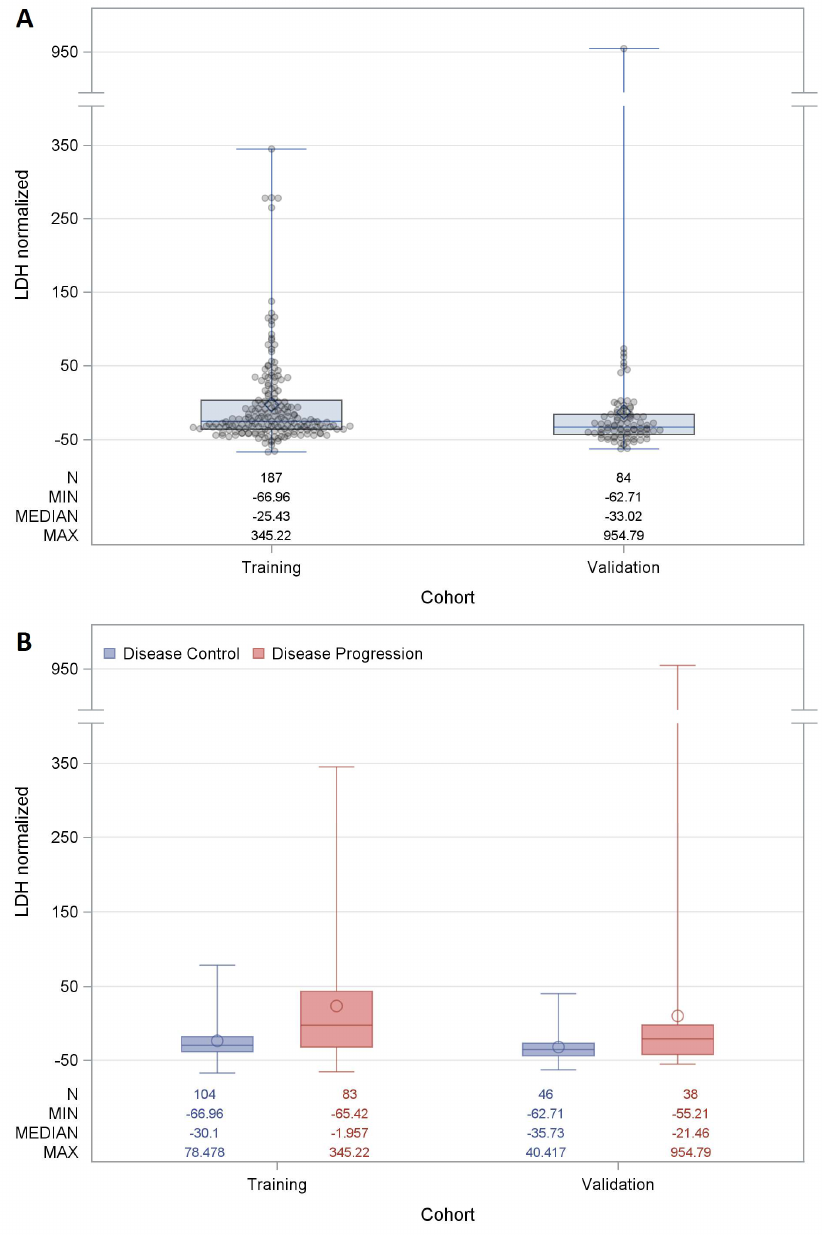
Figure 1. Distribution of lactate dehydrogenase ( LDH ) normalized in the training and validation cohort. ( A ) Boxplots reflecting the distribution of LDH normalized for each patient ( n = 271) distinguished in training and in the validation cohort. Each box indicates the 25th and 75th centiles. The horizontal line inside the box indicates the median, and the whiskers indicate the extreme measured values. Each observation is represented by a grey dot. ( B ) Boxplots reflecting the distribution of LDH normalized according to the best response distinguished in training and in the validation cohort. Each box indicates the 25th and 75th centiles. Blue and red colors indicate disease control and disease progression patients, respectively. The horizontal line inside the box indicates the median, and the whiskers indicate the extreme measured values.